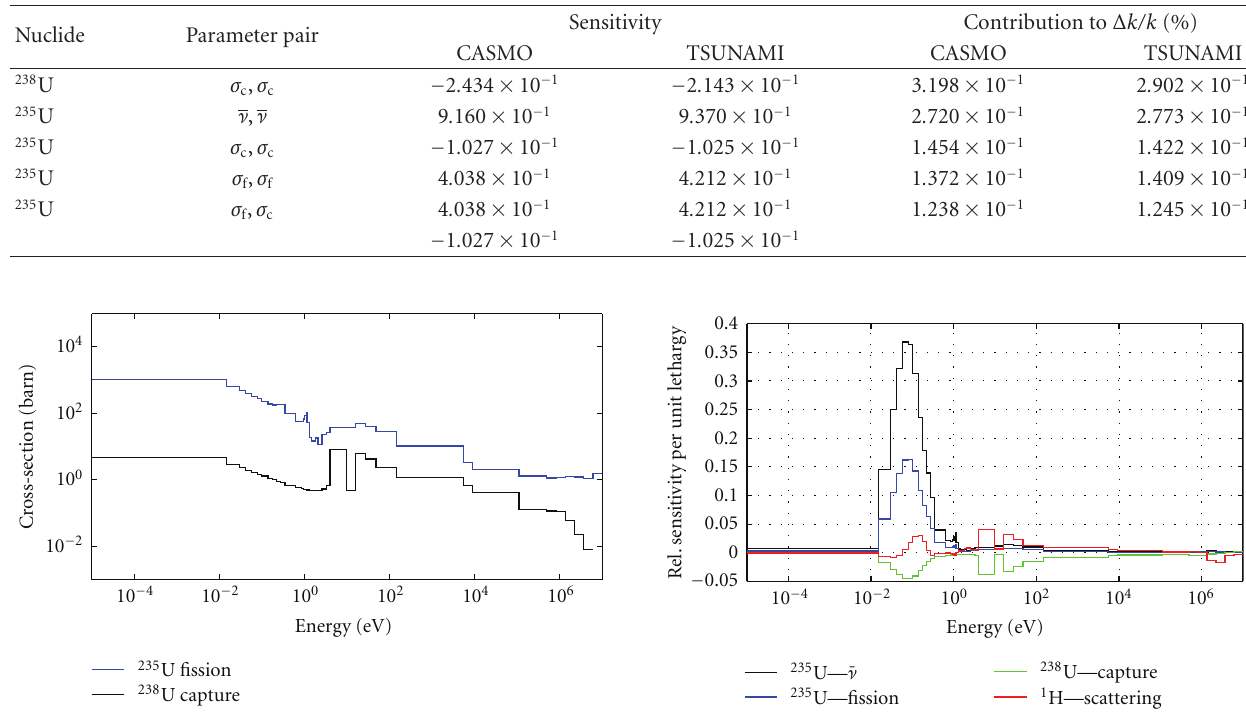
Table 3: The five most significant sources of uncertainty for the multiplication factor and the corresponding energy- and region-integrated relative sensitivity coe ffi cients.